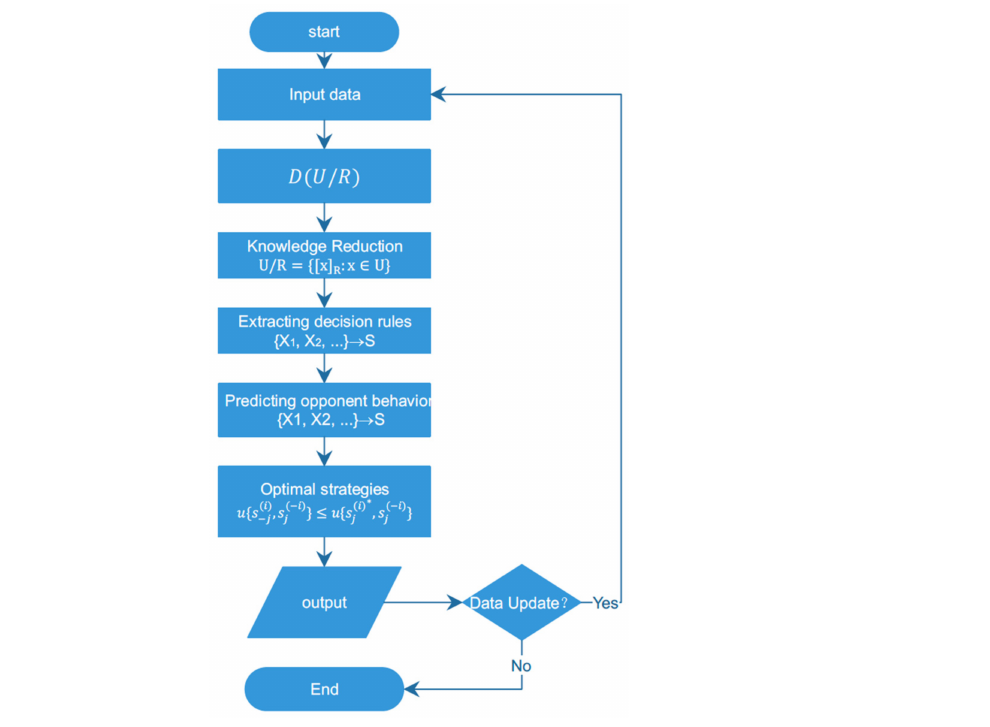
Figure 1. A flow chart for the RS-GT algorithm.